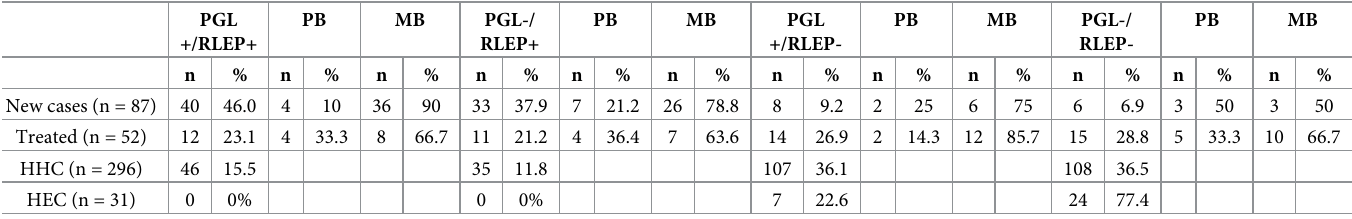
Table 2. Correlation of RLEP and anti-PGL-I titer within each group. PGL